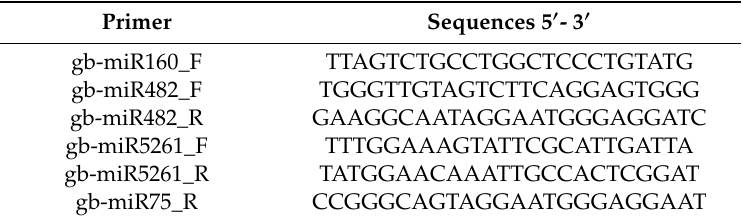
Table 9. Sequences of miRNA-based